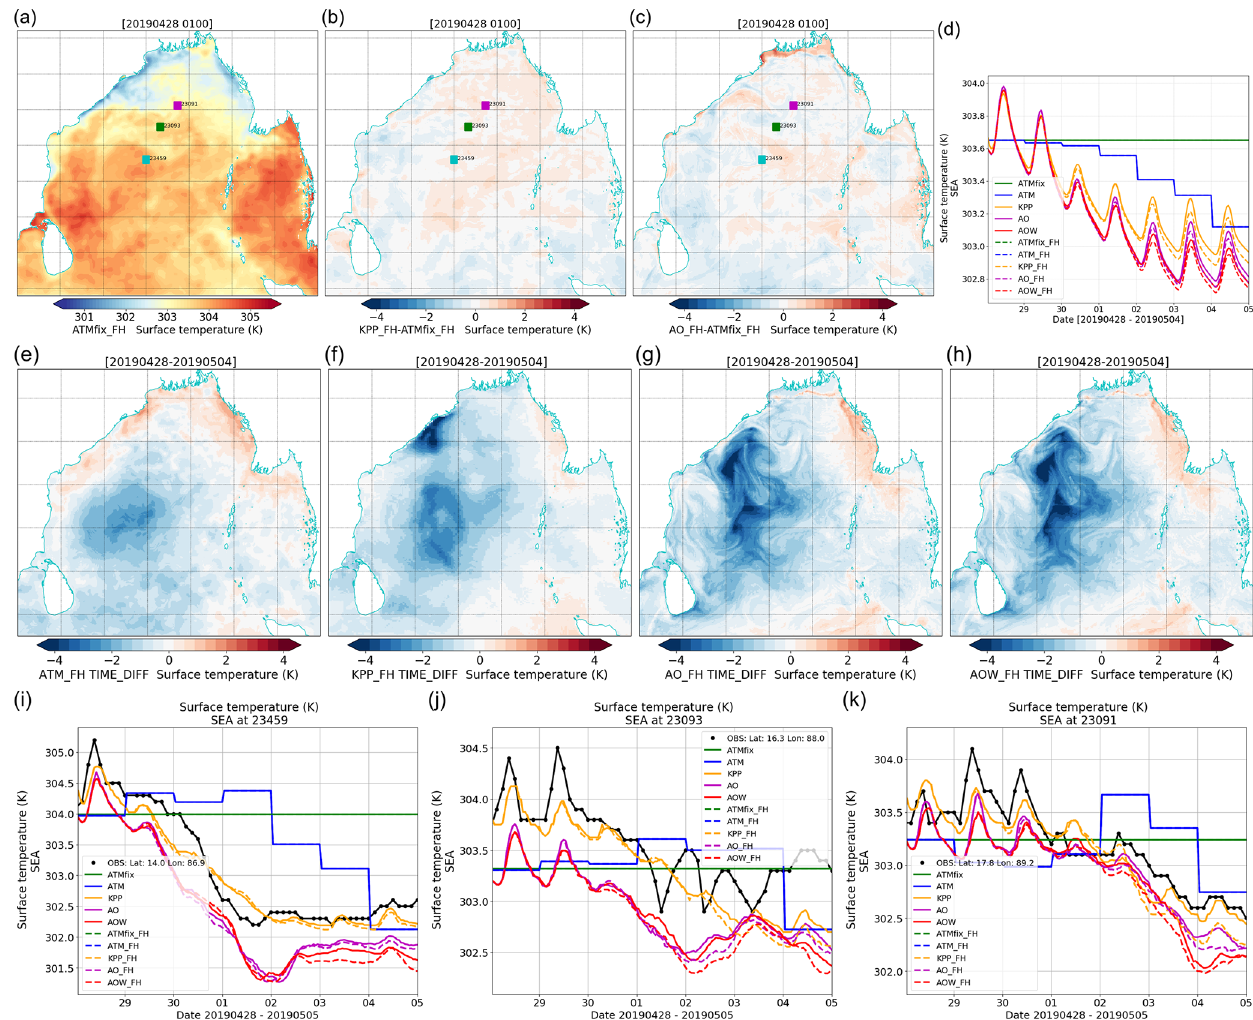
Figure 4. (a) Constant SST field in ATMfix(_FH) control simulation, based on OSTIA data available for forecasting at 00:00UTC on 28 April 2019 for simulations of cyclone Fani (note central scale value of 303K is approximately 30 ◦ C), and (b, c) initial-condition difference in SST for (b) KPP and (c) AO (and AOW) simulations. Note that ATMfix and ATM use same SST on the first day of simulations, and that initial conditions are common to each experiment with/without frictional heating. (d) Time series of regional mean SST for each experiment during the 7d Fani case study, for the sub-domain shown in (a) . (e–h) Difference in SST for ATM_FH, KPP_FH, AO_FH and AOW_FH simulations respectively at run final time compared to run start time, illustrating extent and magnitude of cyclone-induced cooling captured in each simulation. (i, j, k) Comparison of time series of SST from each experiment with in situ ocean buoy observations at 23459, 23093 and 23091 respectively (locations shown in Fig. 1 and panel a – c ). Model data are taken as means in 5 × 5 grid neighbourhood surrounding each buoy location. Simulations without frictional heating are shown as solid lines, with frictional heating with dashed